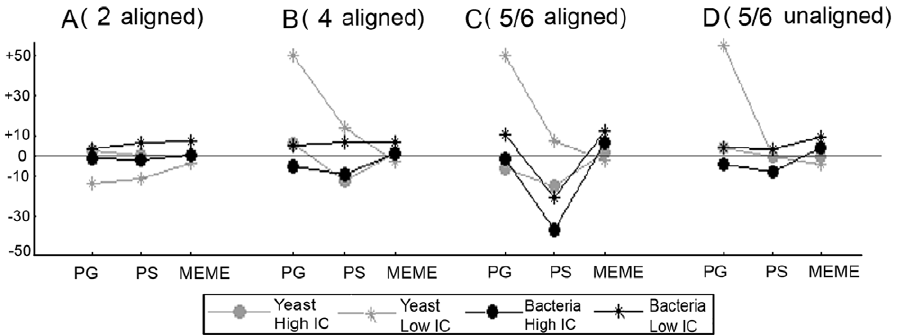
Figure 4. Effect of the number of added orthologs on motif detection in the combined space. Results on the retrieval of both a high and a low IC motif are displayed for the real datasets: 1) results from the Gamma-proteobacterial datasets are indicated as black curves and 2) those of the Saccharomyces dataset are indicated as gray curves. Results for the high IC motif are indicated by circles and correspond to those obtained for LexA (bacterial dataset) or URS1H (yeast dataset), results for the low IC motif are indicated by stars and correspond to those obtained for TyrR (bacterial dataset) or RAP1 (yeast dataset). The panels represent the results of a dataset containing for each coregulated reference gene two (A), four (B) and six (for the bacterial datasets) or five (for the yeast datasets) prealigned orthologs (the reference gene included) (C). Panel (D) represents the results of a dataset containing for each coregulated reference gene six or five unaligned orthologs (the reference gene included). Results were assessed by the F- value defined as the harmonic mean of the spPPV (the percentage of true sites amongst the predicted motif sites for the reference species, averaged over all correct outputs) and the spSens (the percentage of the true sites found by the algorithm for the reference species, averaged over all correct outputs). The reference species are respectively E. coli (bacterial data) or S. cerevisiae (yeast data). The Y-axis represents the difference between the F- value obtained from searching motifs in the combined coregulation-orthology space and the F-value obtained from searching in the coregulation space